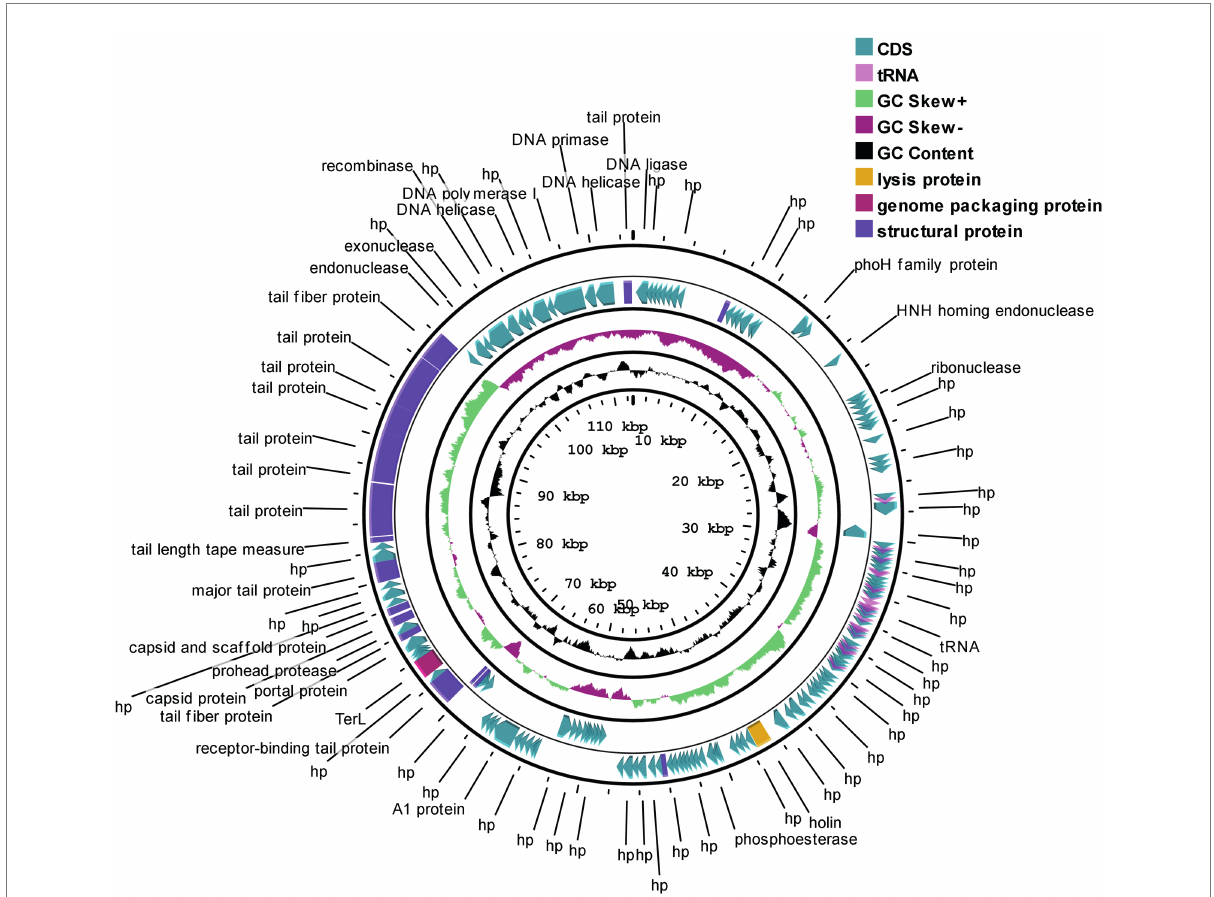
FIGURE 8 Genome structure of phage STWB21 prepared using CGView. The outer ring denotes the STWB21 genome and ORFs. The inner rings show G + C content and G + C skew, where peaks represent the positive (outward) and negative (inward) deviation from the mean G + C content and G + C skew,